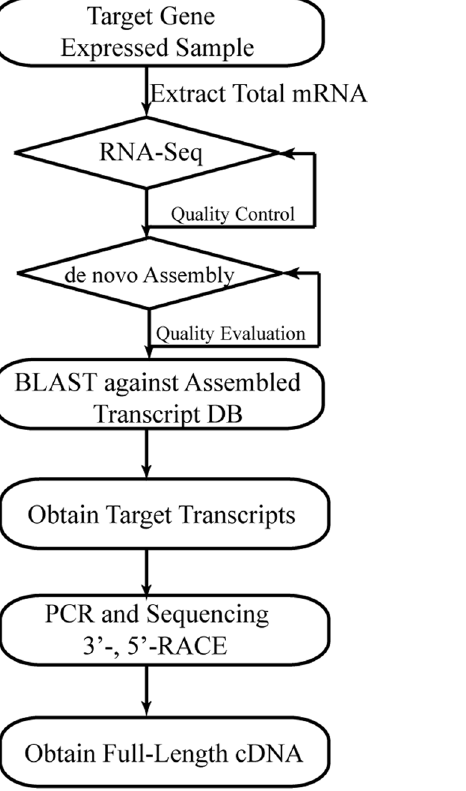
Figure 1. The de novo transcriptome assembly and cloning pipeline. This pipeline has four key steps: (1) Sampling the suitable tissues. Target genes must be relatively highly expressed in the sampled tissues; (2) Transcriptome assembling. The de novo assembly is necessary to obtain the target gene whether we have the reference genome or not; (3) Alignment of the partial target gene protein/EST to the assembled transcripts. We used the reference OC-17 protein sequence (GenBank No.: Q9PRS8) to conduct tBLASTn against the assembled transcripts. (4) RACE. The last step is to use RACE to confirm the assembled transcripts and obtain the full-length